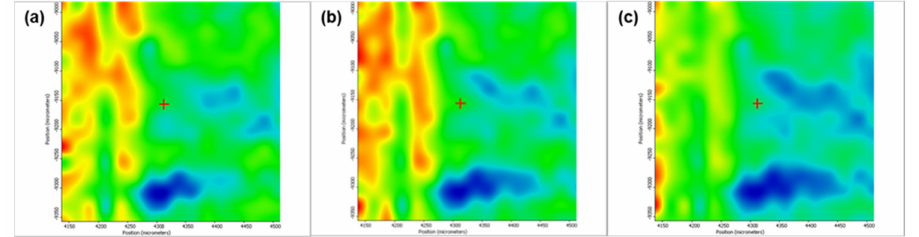
Figure 12. Second derivate IR mappings of Fe 3 O 4 @ β -CD/PTX thin films deposited at F = 500 mJ/cm 2 : surface intensity distribution of ( a ) 2930 cm − 1 , ( b ) 1029 cm − 1 and ( c ) 1739 cm − 1 .